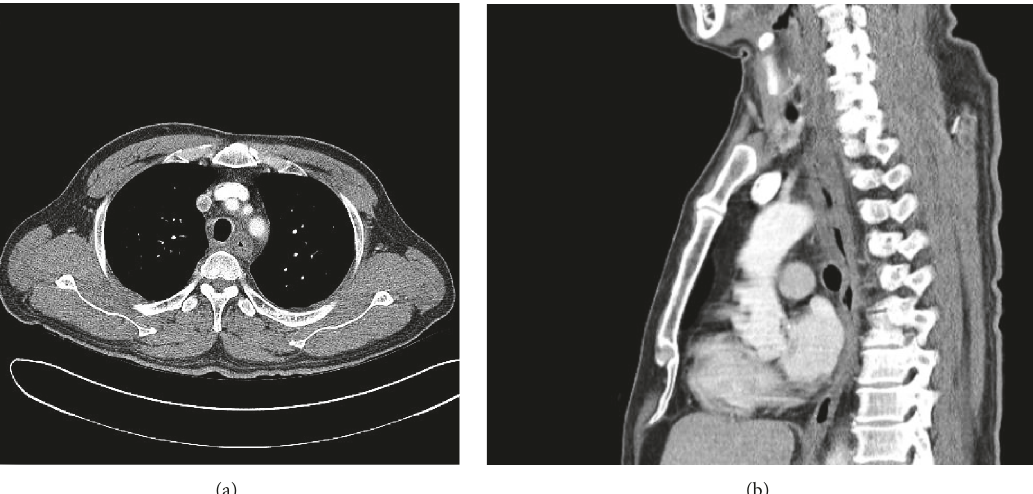
Figure 2: Chest computed tomography (CT). Transverse plain (a) and sagittal plain (b) images of the chest CT showed diffuse esophageal wall edema and thickening. However, esophageal perforation or mediastinitis was not detected.